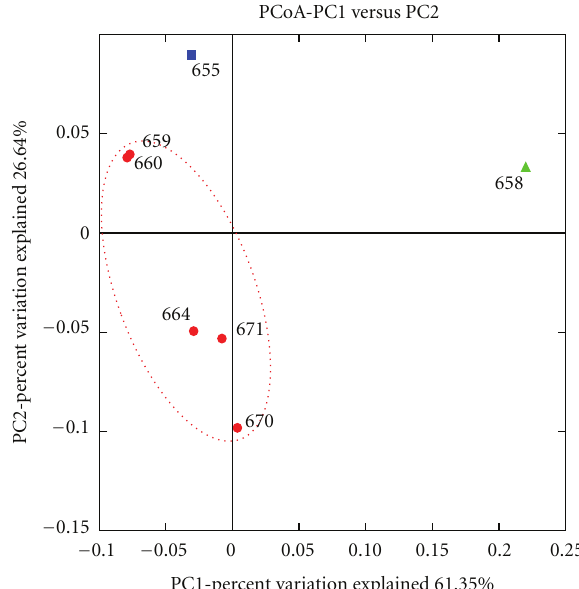
Figure 4: Weighted UniFrac 2D Principal Coordinate Analysis plot for beta diversity analysis. Samples taken during an algal bloom (samples 659, 660, 664, 670, and 671) are shown in red. Sample 655 taken at a river outfall and sample 658 originating from outside the algal bloom in blue and green,